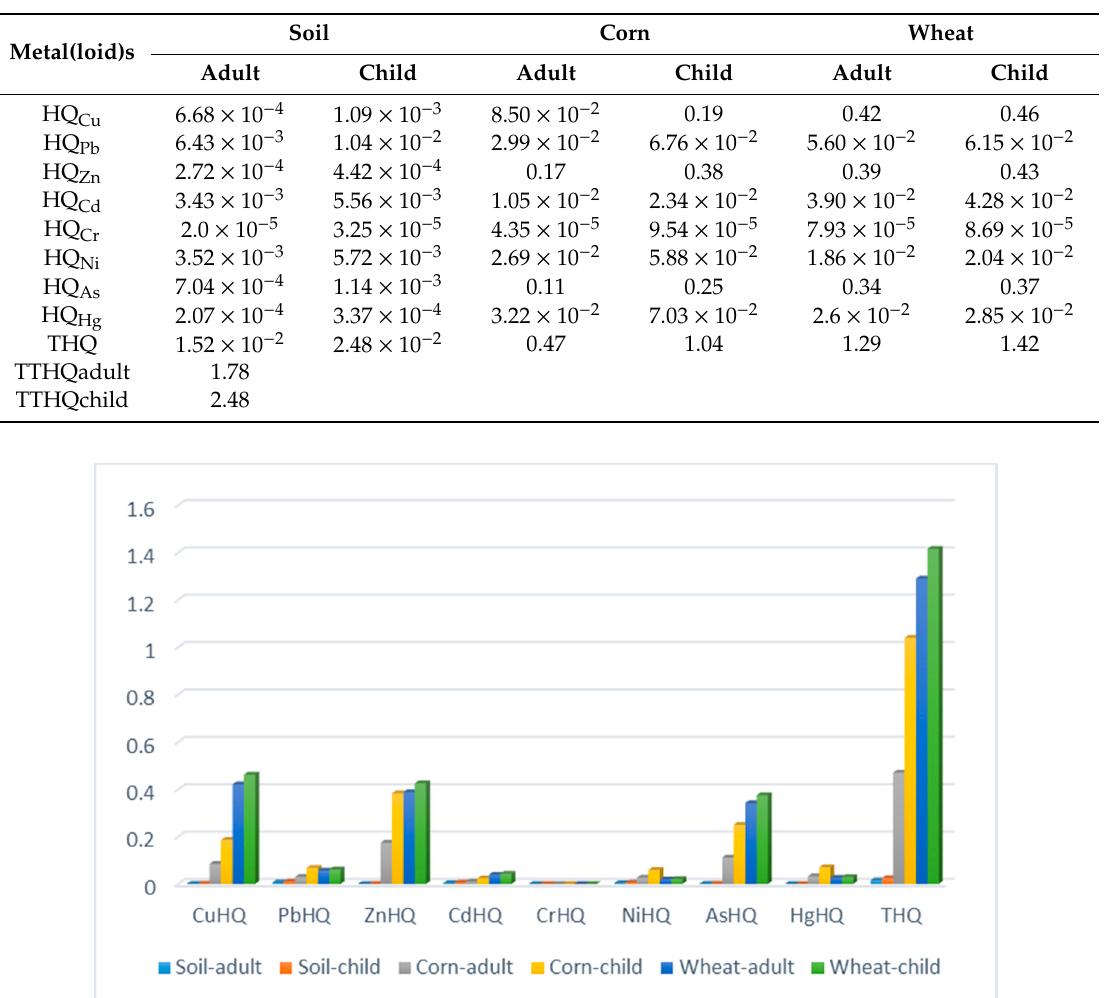
Figure 5. Comparison of the distribution of HQ and THQ under the three paths. The HQ of As, Cu, and Zn in crops is higher than that of the other metal(loid)s. In particular, the HQ of As, Cu, and Zn in wheat all exceed 0.3, with 2% of the As samples in wheat having HQ values greater than 1. Additionally, the contribution of Zn, Cu, and As in crops to total risk was the largest for di ff erent receptor populations, with the three values contributing more than 17%. A valuable finding is that the contribution to risk in wheat exceeded 25% (30.05%, 32.63%, and 26.49%), and the contribution to overall health risk in wheat was more than 80% (Figure 6). The HQ values for Hg (corn 6.79%, and wheat 2.02%), Ni (corn 5.68%, and wheat 1.44%), Cd (corn 2.25%, and wheat 3.02%), Pb (corn 6.46%, and wheat 4.34%), and Cr (corn 0.009%, and wheat 0.006%) in crops contributed to TTHQ values that were less than